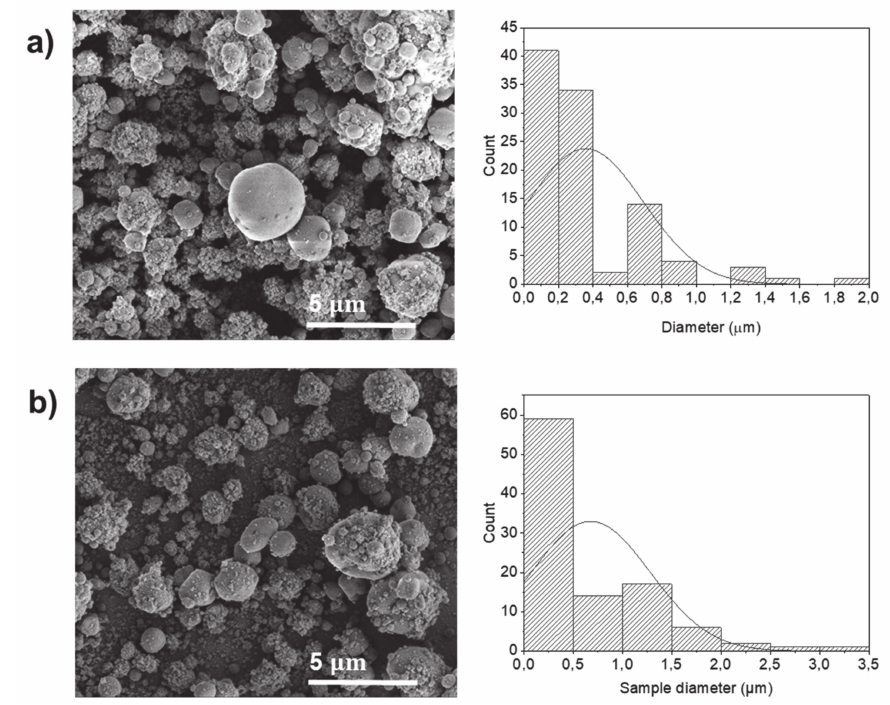
Figure 1. SEM images of electrosprayed potato protein particles, using water as a solvent, and respective histograms displaying their diameter distribution. Samples prepared using 20% w / v protein and processed at voltages of ( a ) 25 kV and ( b ) 30 kV.